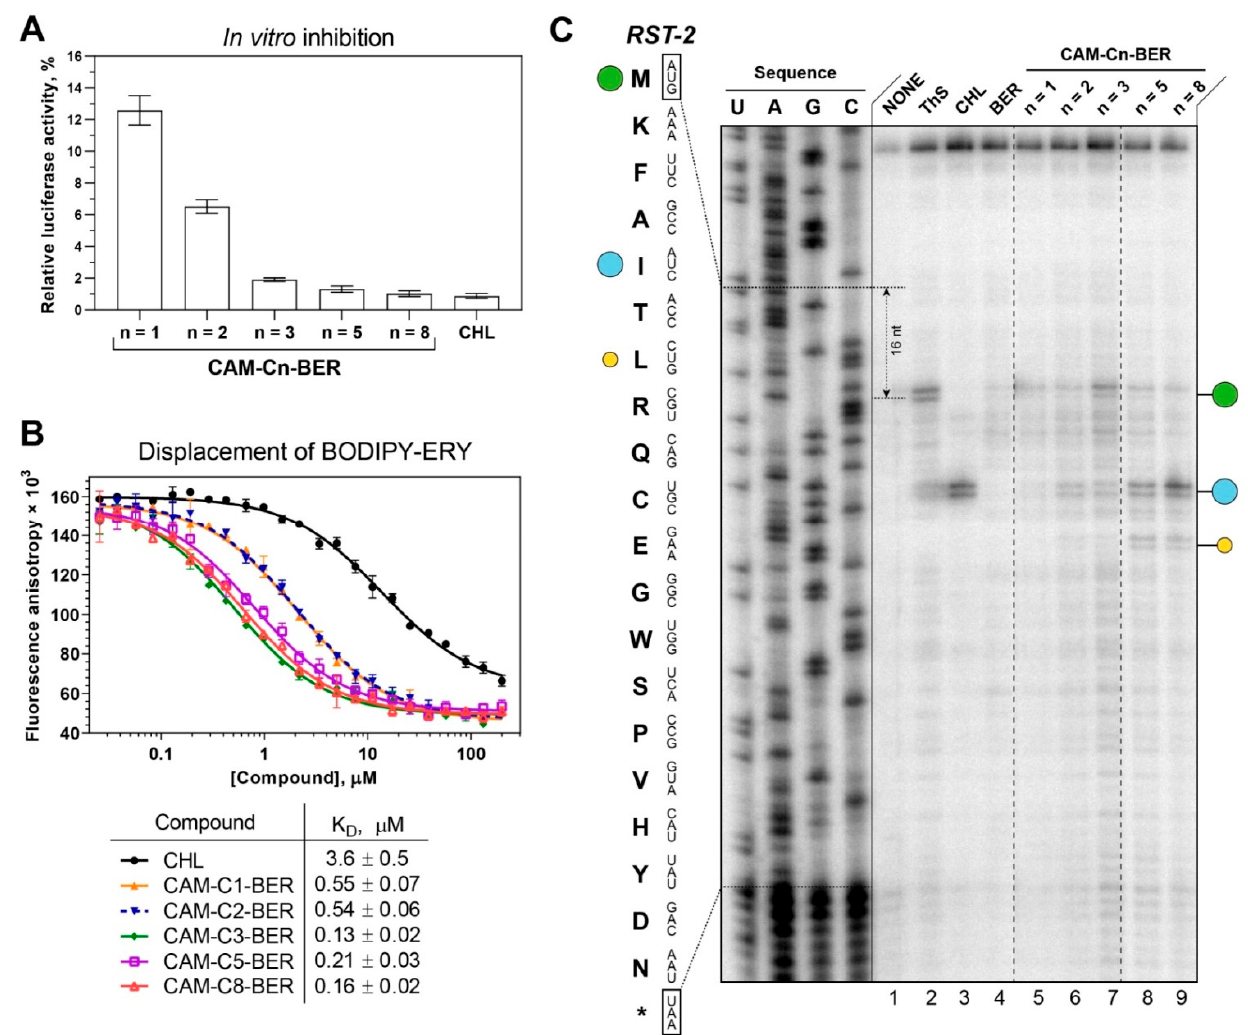
Figure 3. Binding affinity to bacterial ribosomes and the inhibition of protein synthesis by CAM-Cn-BER, n = 1, 2, 3, 5, 8. ( A ) The inhibition of protein synthesis in vitro by 30 µM of CHL and CAM-Cn-BERs in the cell-free bacterial transcription-translation coupled system. The relative enzymatic activity of in vitro synthesized firefly luciferase is shown. The error bars represent the standard deviations. ( B ) A competitive binding assay to test the affinity of CHL and CAM-Cn-BERs to E. coli 70S ribosomes measured by fluorescence anisotropy of fluorescently labeled analog of the erythromycin, BODIPY-ERY. All reactions were repeated at least two times. Error bars represent the standard deviation. The resulting mean values for the apparent dissociation constants (K Dapp ) with confidence intervals ( α = 0.05) are shown in the table below the graph. ( C ) Ribosome stalling by CAM-Cn-BER (n = 1, 2, 3, 5, 8, lanes 5–9) on RST-2 mRNA as detected by a reverse-transcription primer-extension inhibition (toeprinting) assay in a cell-free translation system. DMSO, 0.5% (NONE, lane 1), ThS (inhibits translation at the start codon, lane 2), CHL (lane 3), and BER (lane 4) were used as controls. The nucleotide sequence of RST-2 mRNA and its corresponding amino acid sequence are shown on the left. The green circle marks the translation arrest at the start codon, while the blue and yellow circles denote drug-induced arrest sites within the coding sequence of the mRNA used. Note that due to the large size of the ribosome, the reverse transcriptase used in the toeprinting assay stops 16 nucleotides downstream of the codon located in the P-site. The asterisk (*) indicates a stop codon. Dashed lines mark the places from which parts of the gel were cut out. The full image of the gel is shown in Supplementary Information (Figure S5).